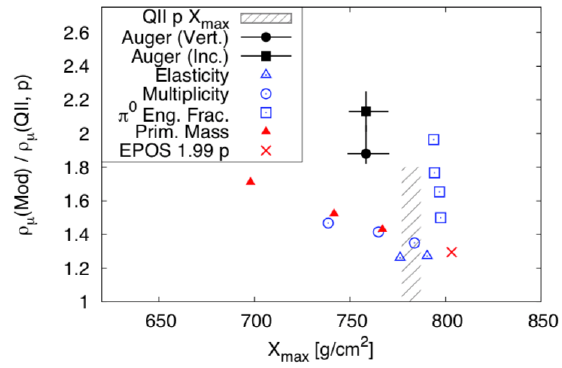
Figure 11. Relative number of muons at 1000 m from the shower core wrt that predicted by QGSJETII-03 as a function of X max . Di ff erent modifications of hadronic interactions are considered [28]. Auger data are also shown as derived from showers of 10 19 eV for vertical and horizontal